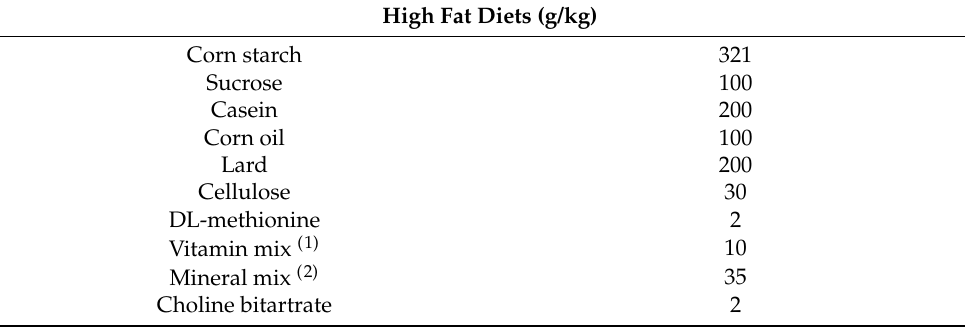
Table 5. Composition of high fat diet